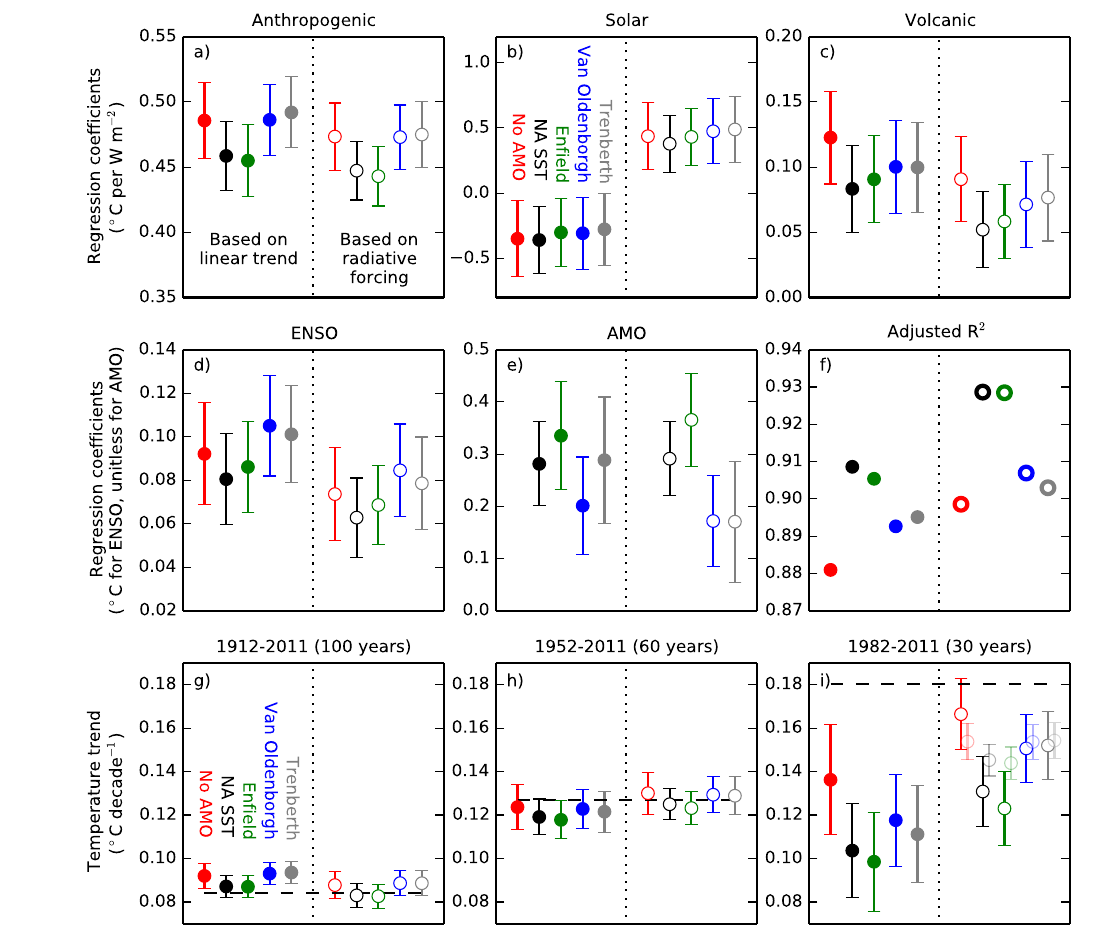
Figure 2. Regression coefficients (a–e) , adjusted coefficient of determination (f) , and calculated anthropogenic trends as well as observed temperature trends (dotted black lines) for three different time windows (g–i) for MLR exercises over the 1900–2011 period using GISTEMP temperature data. Light-colored bars in (i) are calculated anthropogenic temperate trends based on the regression coefficients shown in (a) and the change in forcing. Results are shown for 10 different MLR exercises, with the first five (closed circles) based on a linear trend for the anthropogenic influence and the second five (open circles) using IPCC AR5 anthropogenic radiative forcing instead. Within these two sets, five MLRs were done: one without AMO and four with different AMO descriptions as indicated in (b) and (g) . Error bars indicate 5 and 95 percentiles, without taking uncertainties in input data sets into account.